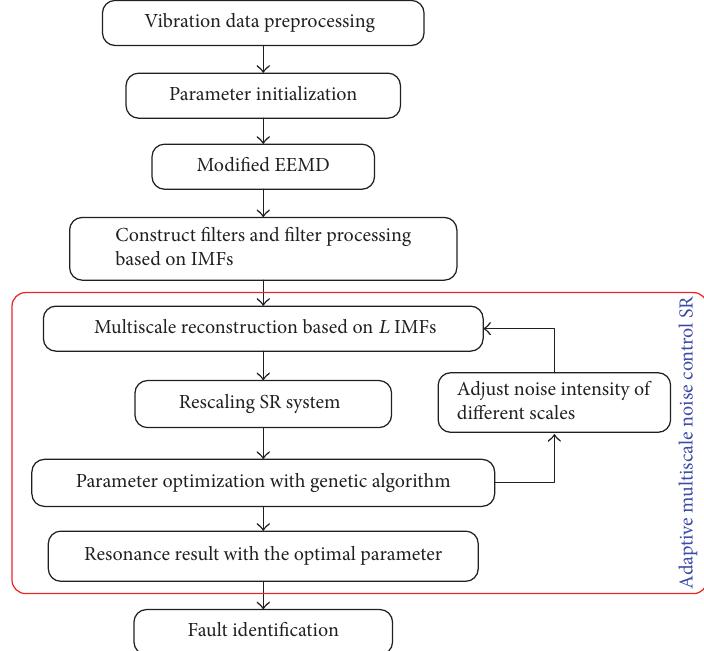
Figure 2: Flow diagram of adaptive multiscale noise control enhanced SR algorithm based on modified EEMD.